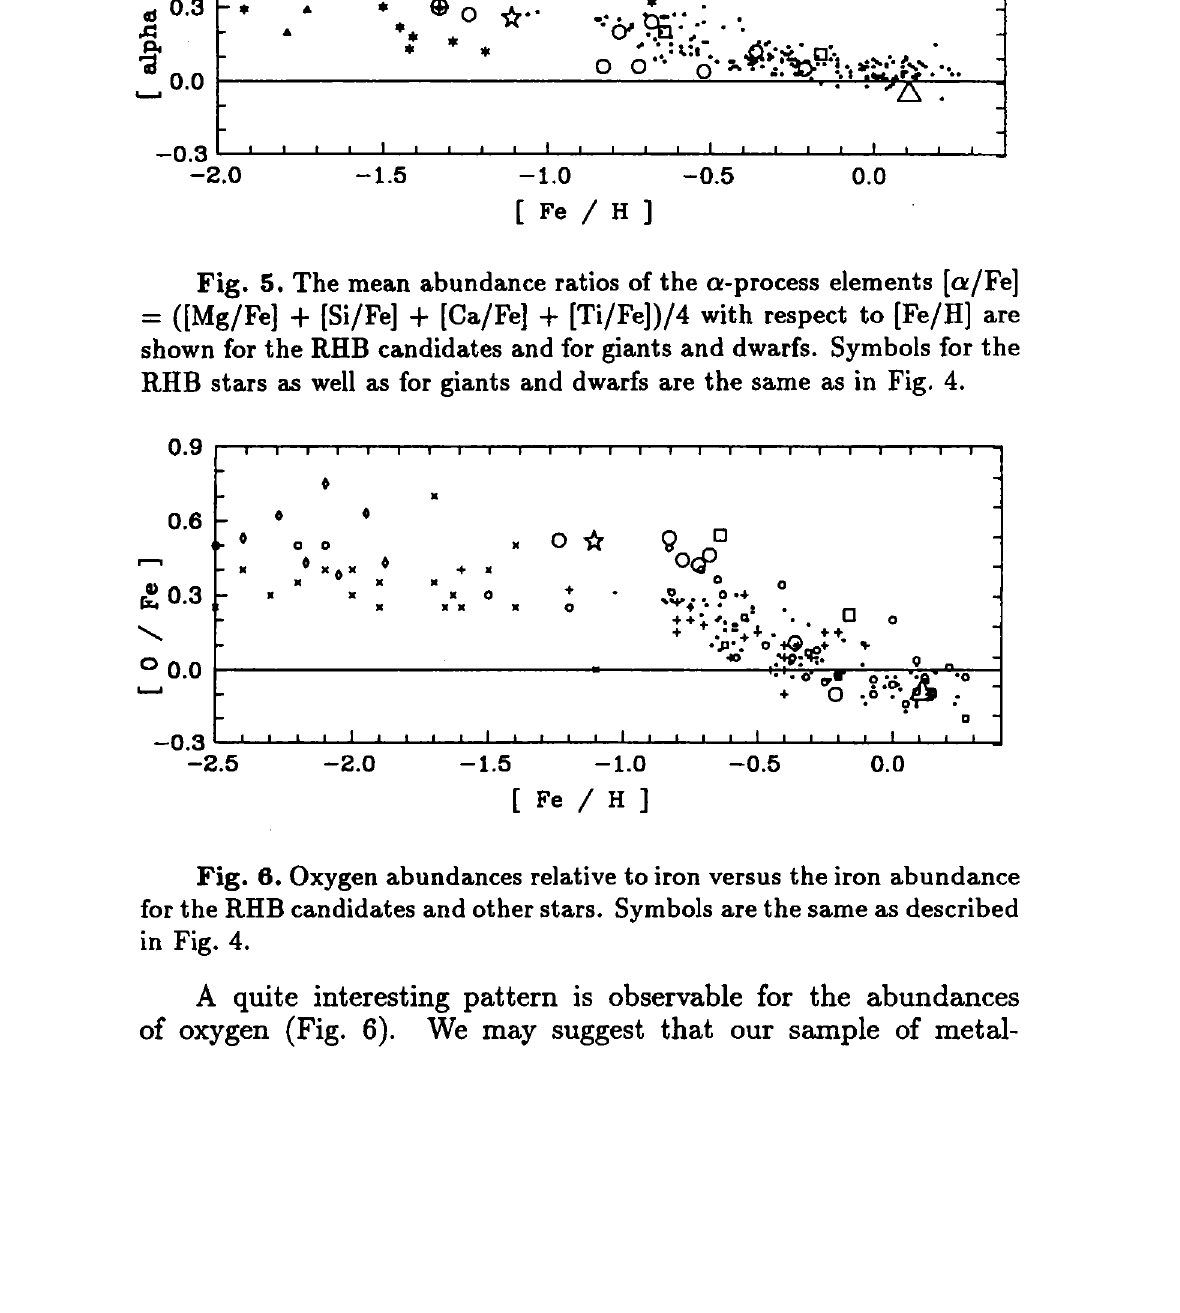
Fig. β. Oxygen abundances relative to iron versus the iron abundance for the RHB candidates and other stars. Symbols are the same as described in Fig.